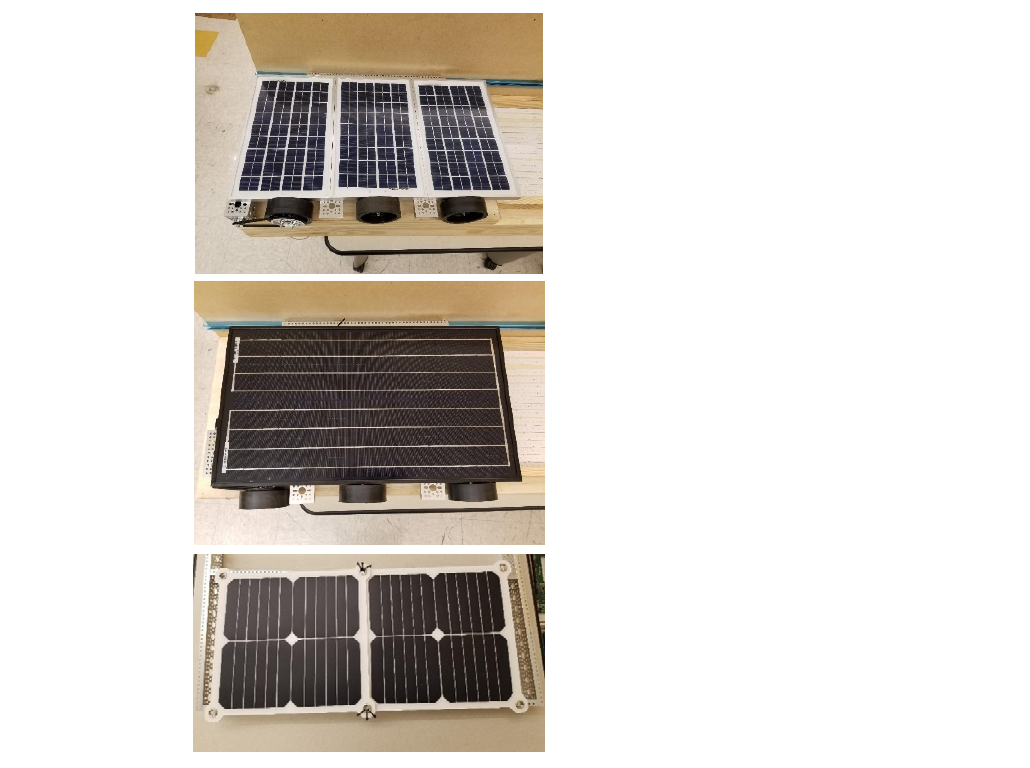
Figure 7. Three solar panel frames constructed for lab-scale prototype: Top to bottom: Three 10 W EcoWorthy ® , 30 W Renogy ® , 2–13 W SunKingdom ® . EcoWorthy ® , 30 W Renogy ® , 2–13 W SunKingdom ®